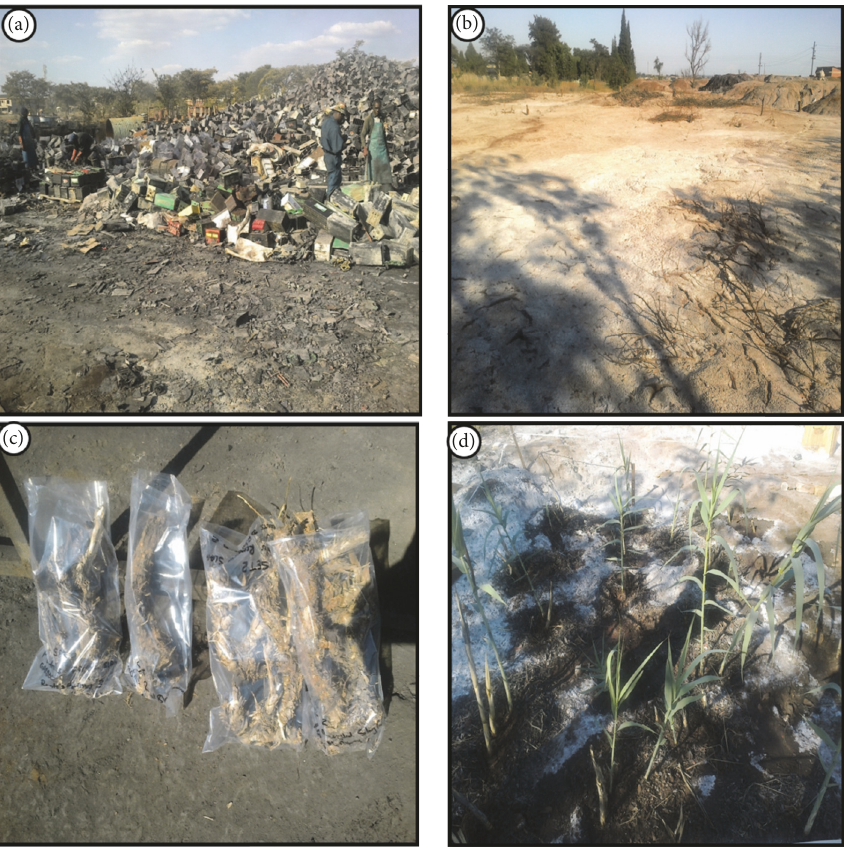
Figure 1: (a) Battery breaking and (b) slag dumpsite with dead vetiver grass within 3 days of planting, at a Lead-Acid Battery recycling and smelting site in Norton, Zimbabwe. (c) P. australis rhizomes before preparation for planting and (d) P. australis growing in an experimental bed of soil with recycled